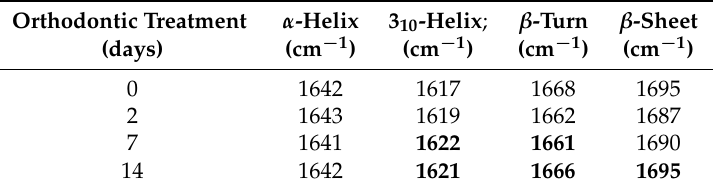
Figure 5. Deconvolution of PDL Raman spectra in Amide I region. The data were obtained by averaging the Raman response of samples extracted after ( a ) 2 days, ( b ) 7 days, and ( c ) 14 days of OTM. α -helix component, red line; other main components, blue lines. Table 2. Raman Amide I band deconvolution of PDL samples at different stages of orthodontic treatments. Bold fonts, Gaussian-shaped peaks; normal fonts, Lorentzian